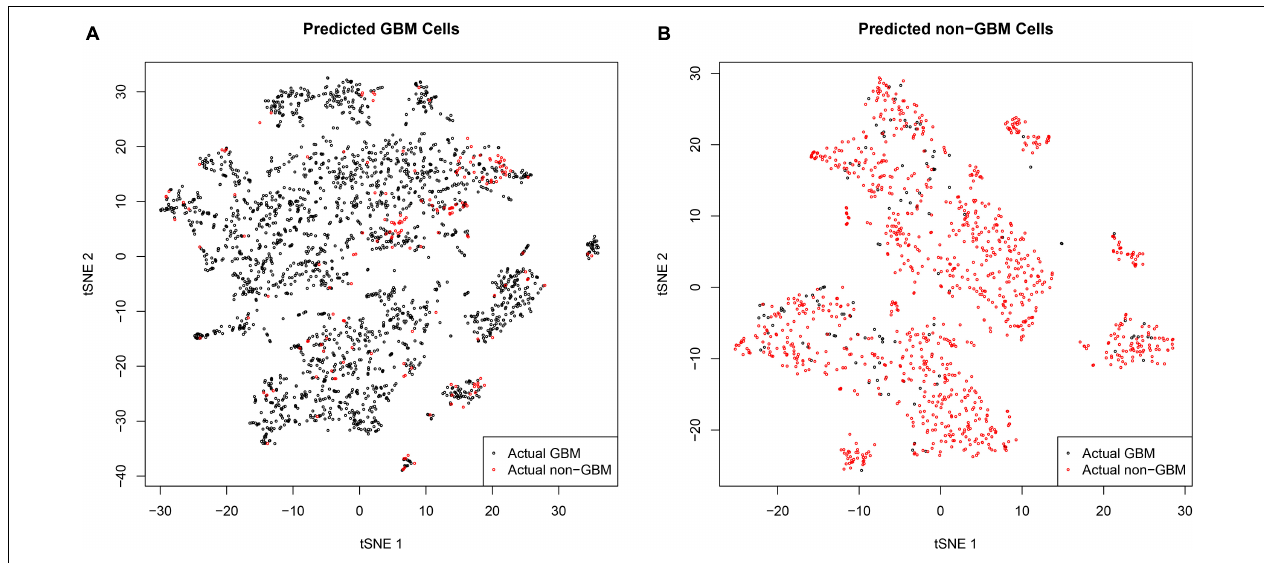
FIGURE 2 | The t -SNE plots of predicted GBM cells and predicted non-GBM cells. (A) The t -SNE plots of predicted GBM cells. It can be seen that the false positive samples (red dots) and the true positive samples (black dots) were mixed and they were difficult to classify. (B) The t -SNE plots of predicted non-GBM cells. It can be seen that the false negative samples (black dots) and the true negative samples (red dots) were mixed. These t -SNE plots suggested that the GBM tissues may contain non-GBM cells and the non-GBM tissues may contain GBM cells, but most cells from the corresponding tissue were similar and the machine learning algorithm we used can get the robust single cell biomarkers even when there were tissue purity issues.